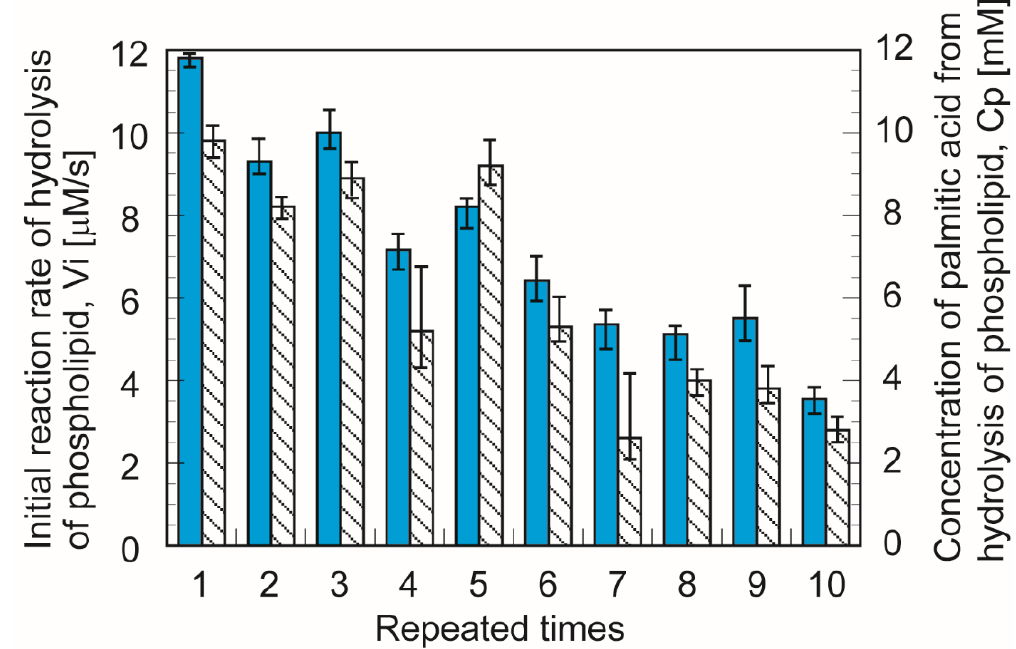
Figure 10. Comparison of the repeated initial reaction rate and reaction yields of hydrolysis with immobilized phospholipase A 1 (Hb: 0.075 mL, C GA : 6%). : Initial reaction rate, Vi. : Reaction product (palmitic acid) concentration, Cp.